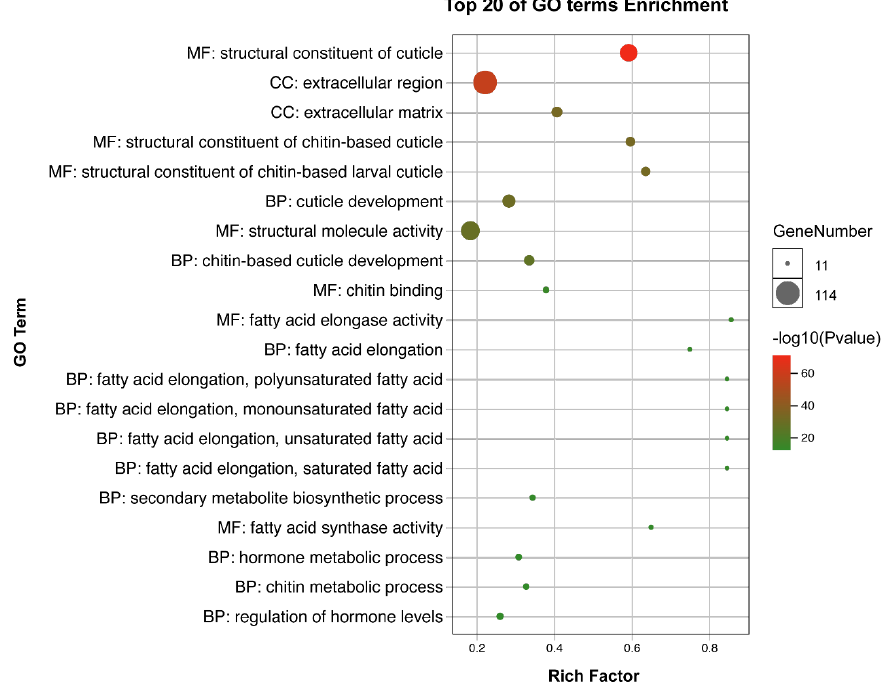
Figure 4. Knockdown of NlFoxN1 in nymphs affected the molting process. ( a ) The survival rate after NlFoxN1 -RNAi in the fifth instar. ( b,c ) The lethal phenotypes after injection of dsRNA for NlFoxN1 in the fifth instar ( b ) and the fourth instar ( c ). dsRNA (50 ng per insect; n = 100) was injected into BPHs at the very beginning of each instar. ds GFP was injected as a negative control for the nonspecific effects of dsRNA. Mean ± s.e.m. from three experiments. *** p < 0.001 (Student’s t -test), difference from ds GFP .